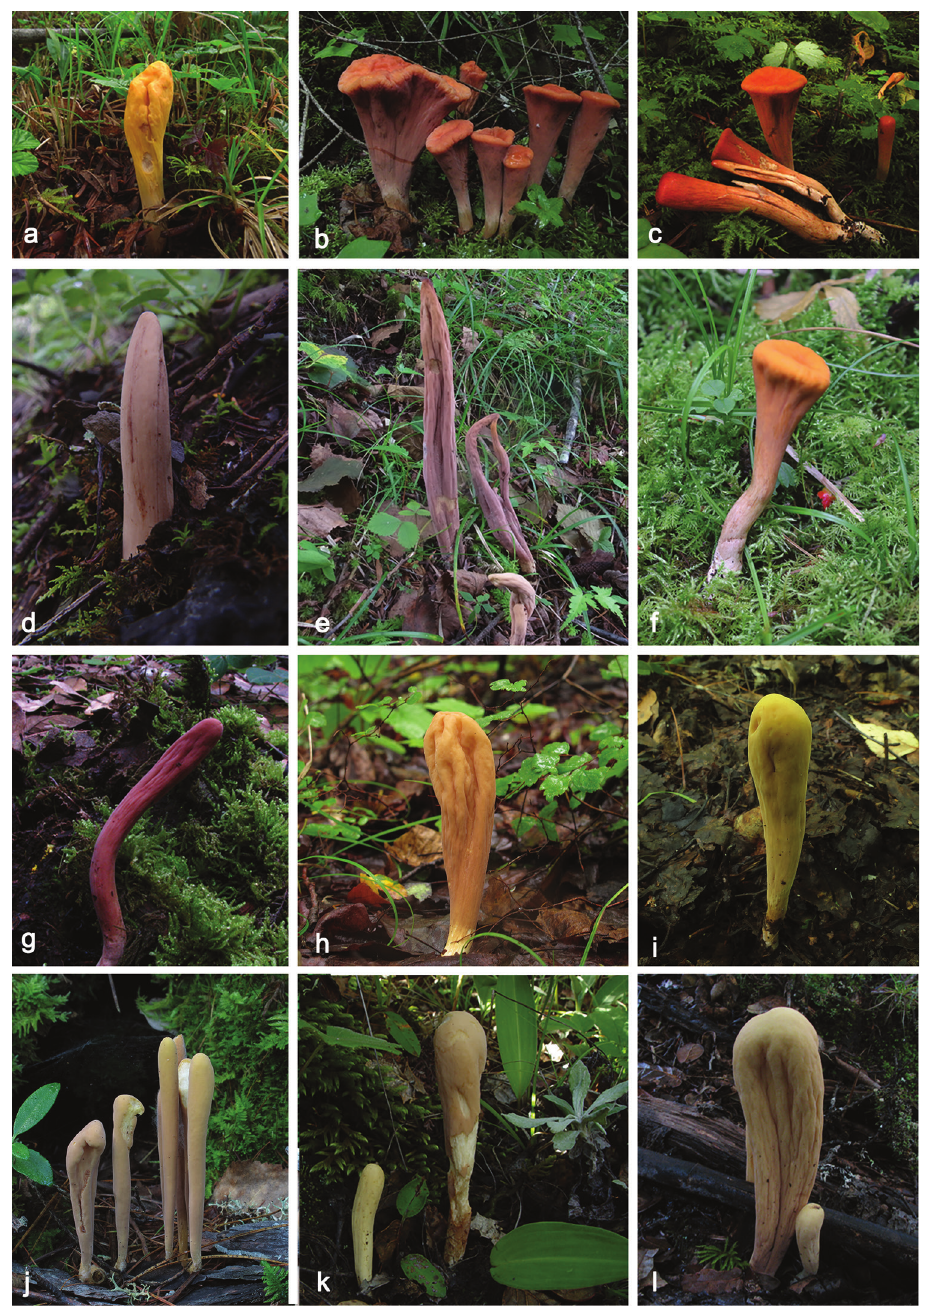
Figure 2. Clavariadelphus species in China. a C. alpinus (HKAS 57396, holotype) b, c C. amplus (HKAS 54876, holotype) d, e C. elongatus ( d from HKAS 50742 e from HKAS 76589) f C. gansuensis (HKAS 76487, holotype) g C. himalayensis (HKAS 58811) h, i C. khinganensis ( h from MHHNU 7789, holo- type i from MHKMU H.Y. Huang 368) j C. sachalinensis (MHHNU 7816) k, l C. yunnanensis ( k from HKAS 49398 l from HKAS